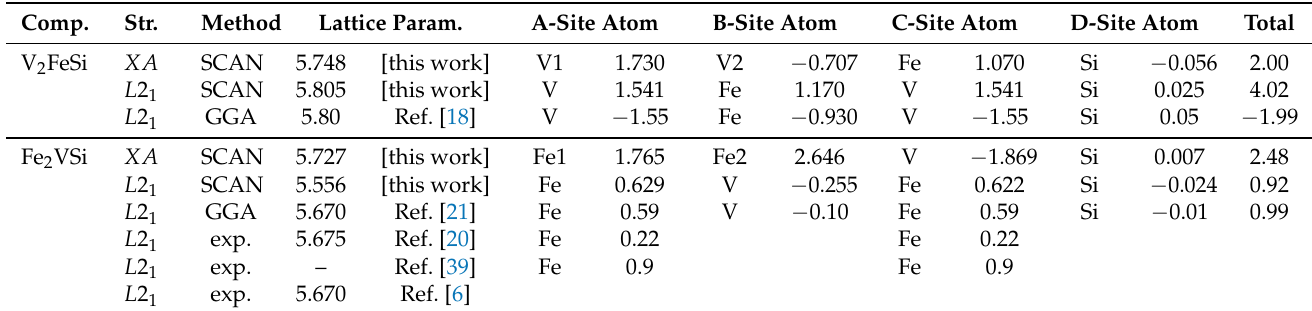
Table 2. Calculated lattice parameters (Å) and magnetic moments ( µ B ) of V 2 FeSi and Fe 2 VSi in regular and inverse structures in comparison with available theoretical and experimental